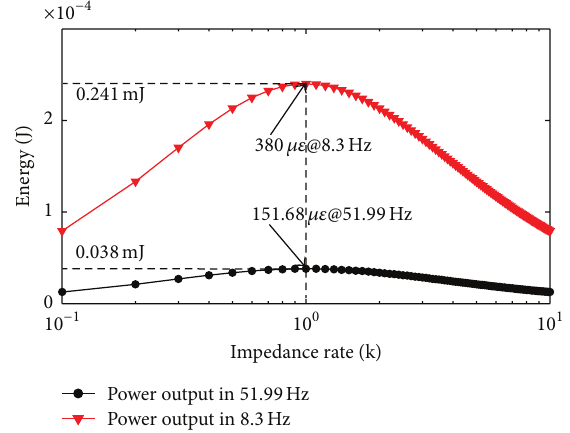
Figure 11: Impedance rate-power output curve in two vibration